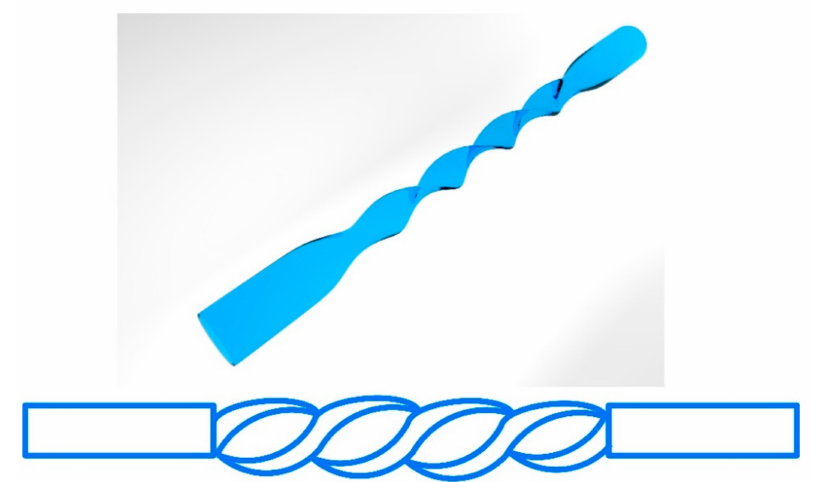
Figure 14. The schematic diagram of the screw-shaped POF